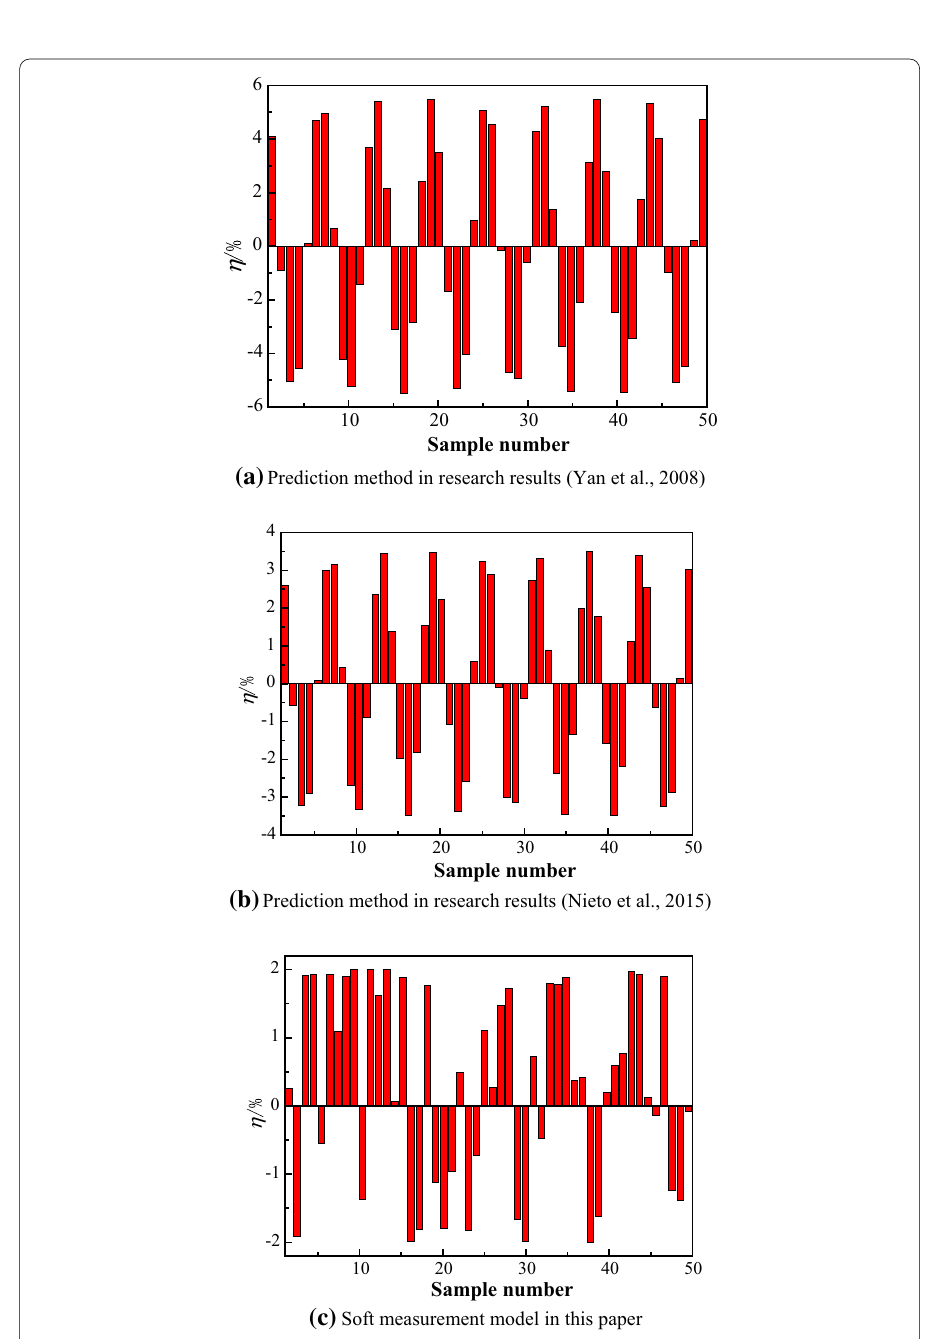
Fig. 5 Comparison of relative error between predicted value and actual